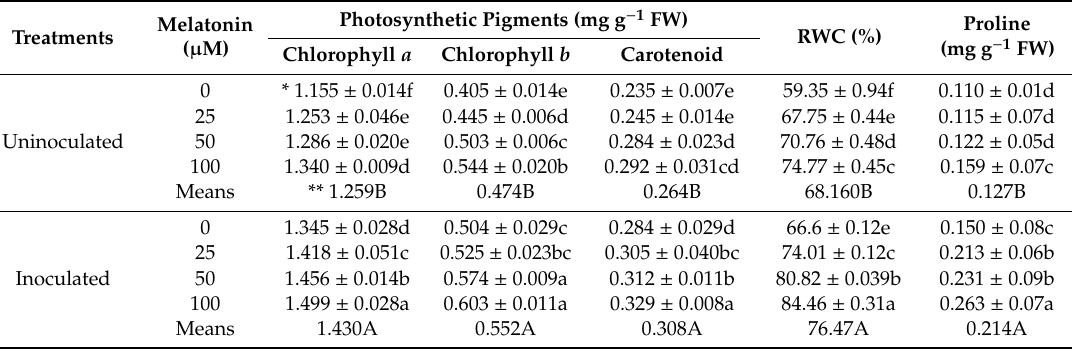
Table 7. E ff ect of EPS-producing bacteria and melatonin on photosynthetic pigments, RWC%, and proline content of faba bean plants grown in location two (non-saline